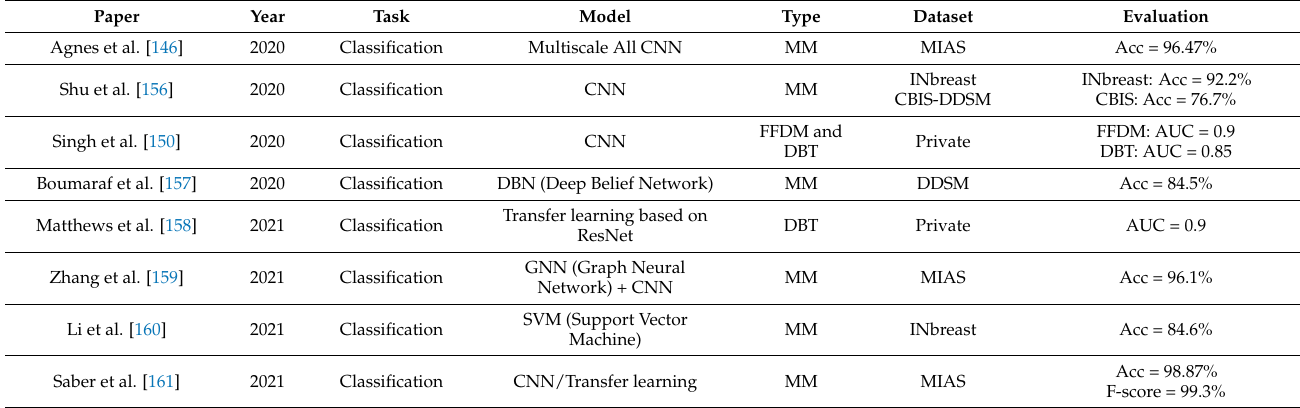
Table 3. The summary of the studies that used MM and DBT datasets.